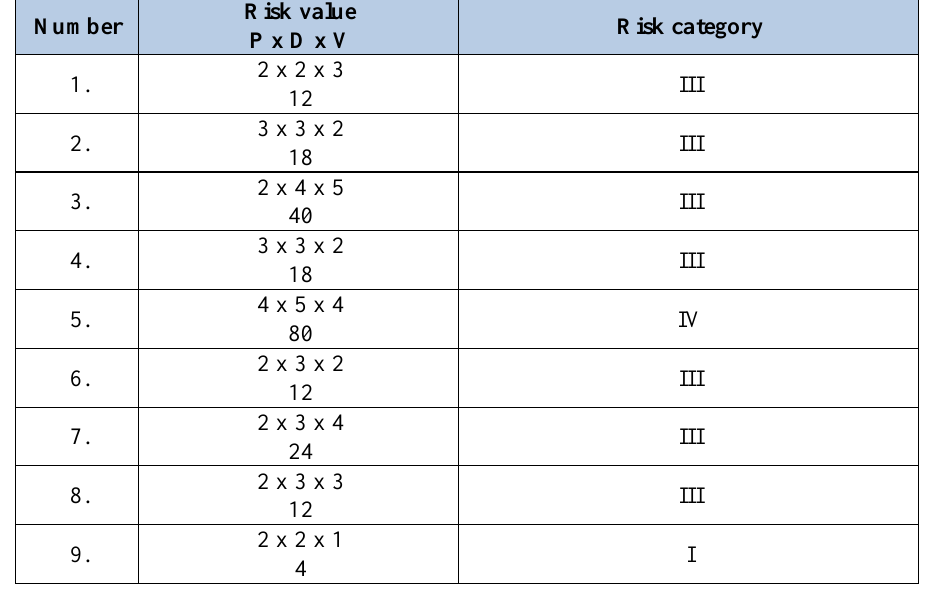
Table 7 Results of point